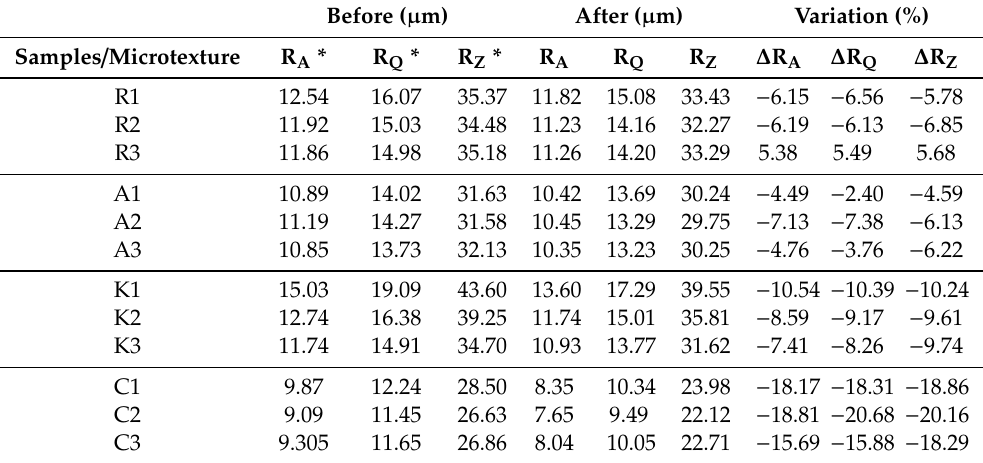
Table 6. Roughness data collected by profilometric analysis (baseline length ≈ 200 µ m).